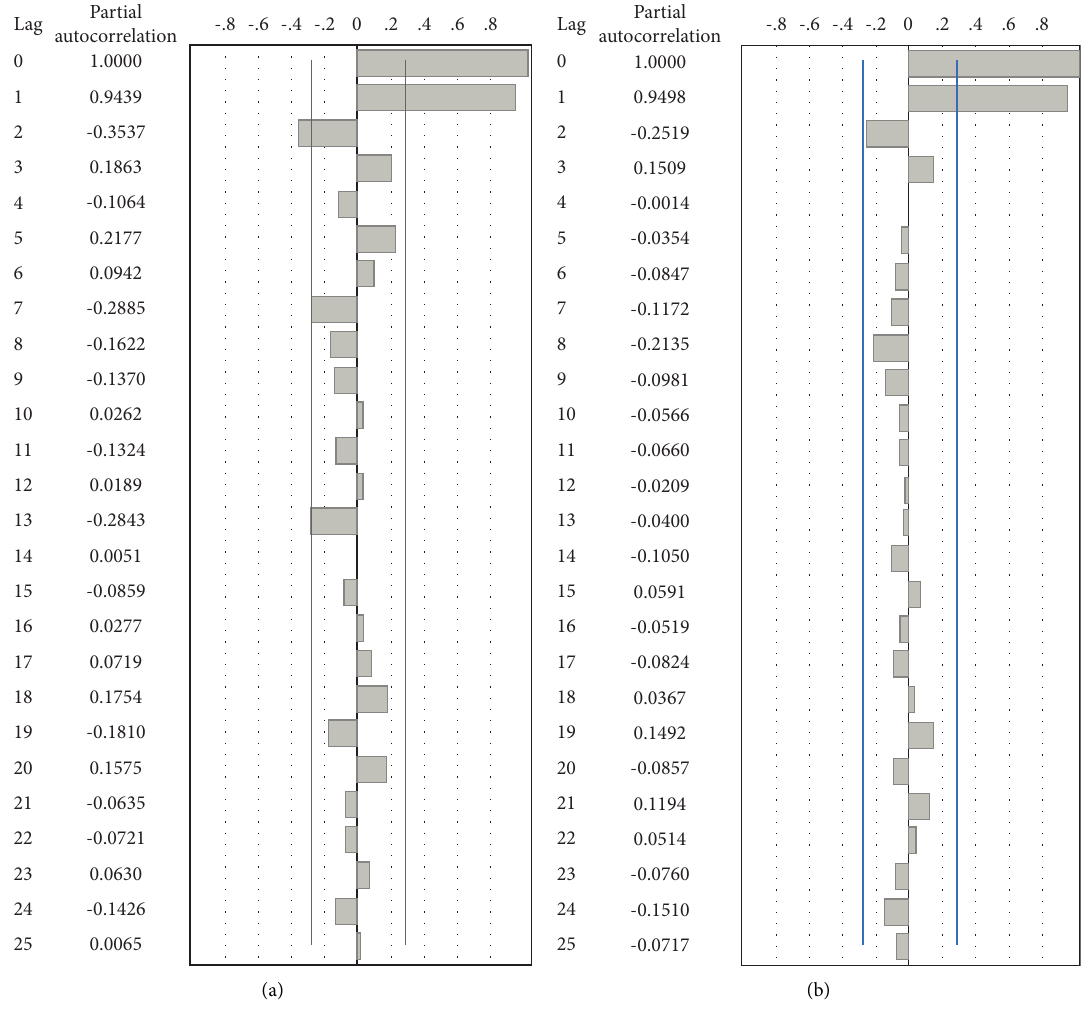
Figure 12: Partial autocorrelation coefcients of Fe 2 O 3 -asphalt model (a) and SiO 2 -asphalt model (b) in the OX